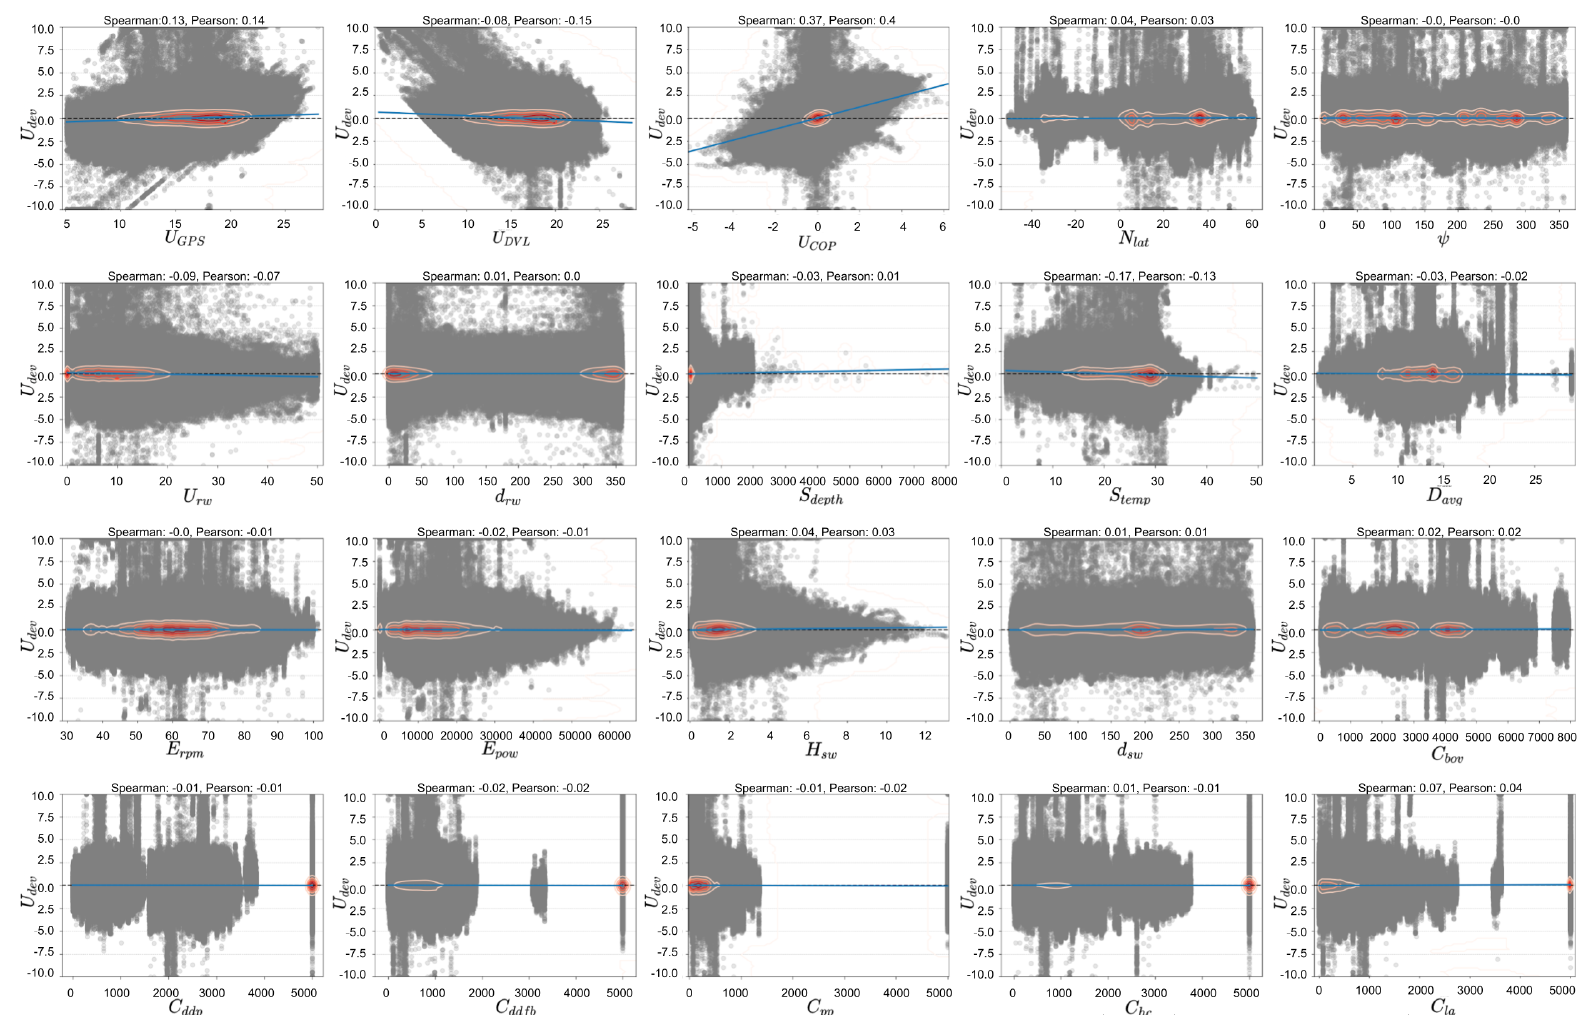
Figure 20. Linear correlation density scatterplot of U dev versus the rest of the continuous features of the main